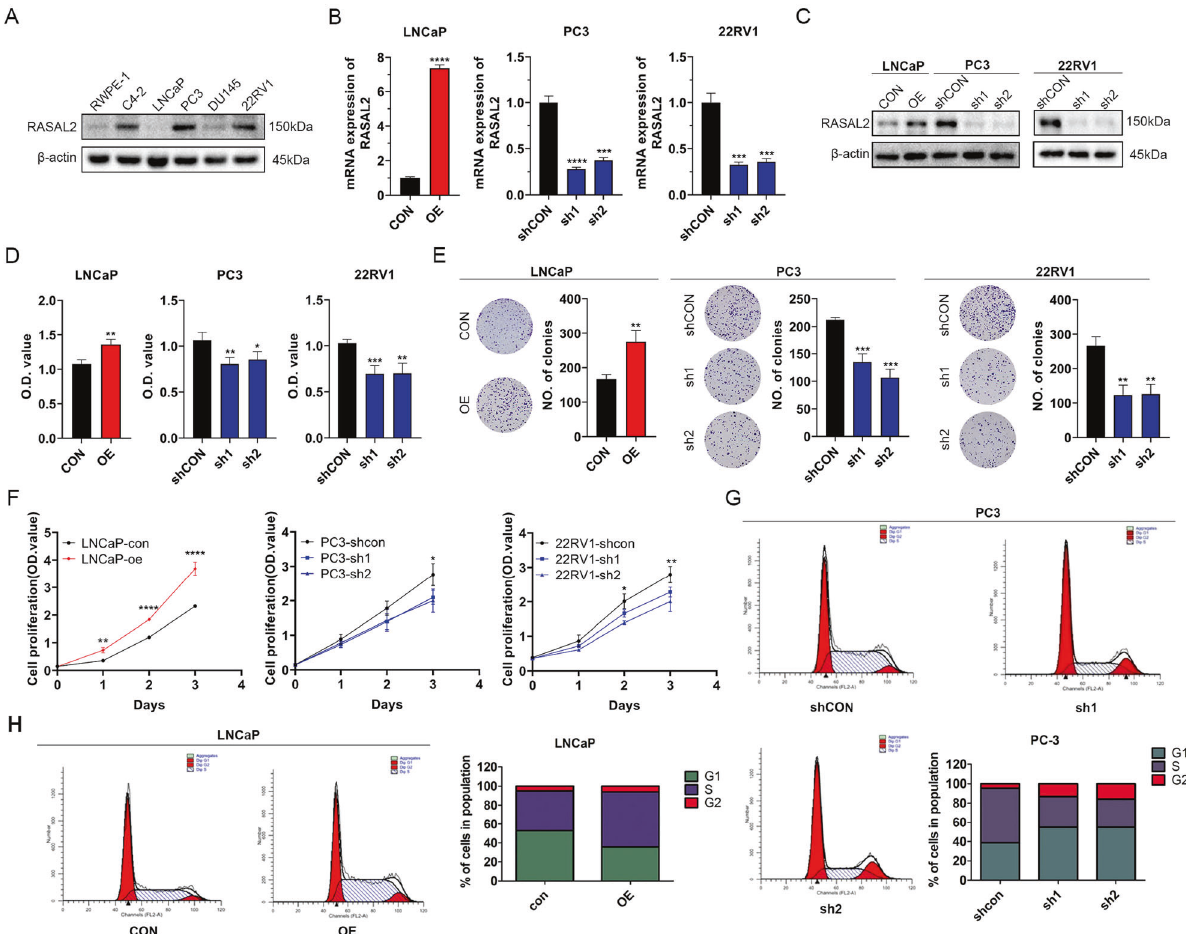
Fig. 2 Expression of RASAL2 in PCa cell lines and the effects of RASAL2 on the proliferation of PCa cell lines. A Western blotting analysis of RASAL2 expression levels in human nontumor prostate and PCa cell lines. B , C Quantitative real-time RT – PCR and Western blotting analysis of RASAL2 expression in 22RV1 or PC3 cell lines transfected with RASAL2 shRNAs and shControl and LNCaP cell lines infected with RASAL2 lentivirus and negative control. D Cell activity assay for established cell lines. E Clone formation experiments with quantitative results on established cell lines. F Cell proliferation experiments on established cell lines. G , H Cell cycle analysis of PC3 and LNCaP cell lines using fl ow